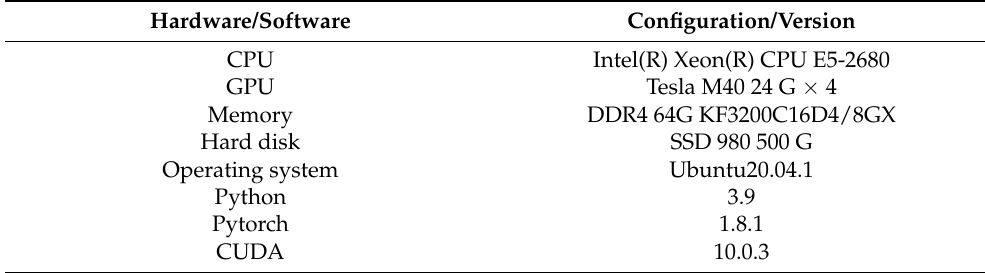
Table 4. The basic parameters of the industrial